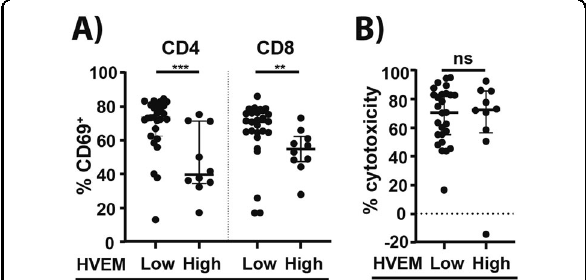
Fig. 3 Lower T-cell activation by epcoritamab in presence of tumor cells with high expression of the immune regulatory molecule HVEM. A CD69-positive CD4 + and CD8 + allogeneic T-cells after treatment of B-NHL samples with epcoritamab (30 ng/mL) and CD3xCtrl (30 ng/mL) in samples with low or high tumor HVEM expression levels (Mann – Whitney U -test; *** p < 0.001, ** p < 0.01). B Epcoritamab-dependent cytotoxicity (30 ng/mL) in B-NHL samples with low and high tumor cell HVEM expression (Mann – Whitney U -test; ns). HVEM expression on healthy donor B-cells was used as cut-off value to stratify between low and high expression. Data are shown as median ±interquartile range. All samples from different B-NHL subtypes and from ND and RR are plotted